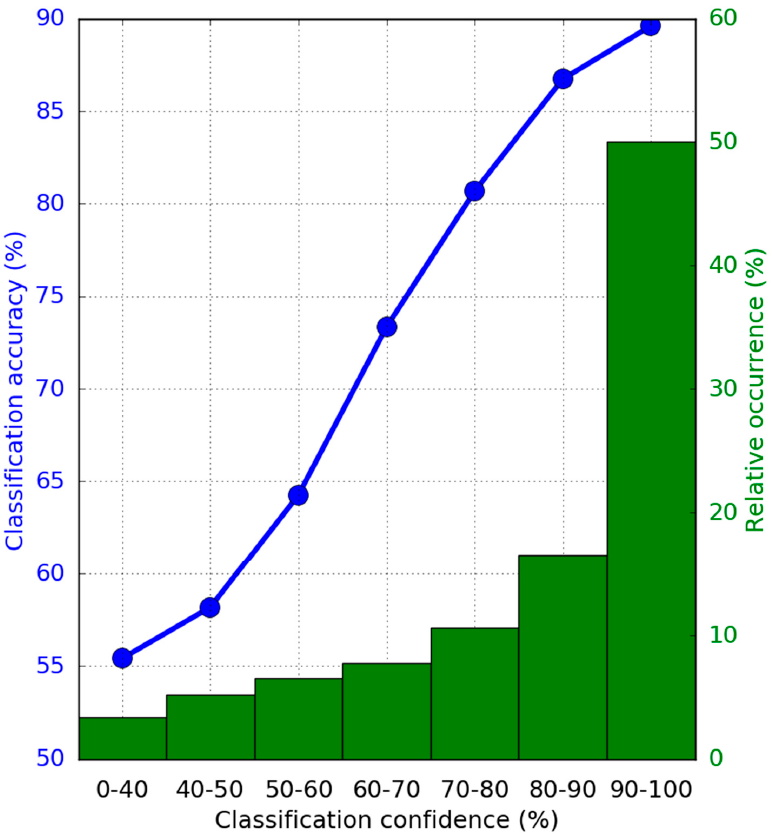
Figure 9. Mean classification accuracy as a function of classification confidence as well as the relative occurrence of each confidence level. These numbers were calculated by binning all validation samples according to their classification confidence as reported by the RF classifier and calculating the mean classification accuracy for all validation points within a particular confidence bin. This analysis clearly demonstrates the strong correlation between accuracy and confidence, meaning that the confidence level can be qualitatively used to assess the expected accuracy of the classification in a specific region.